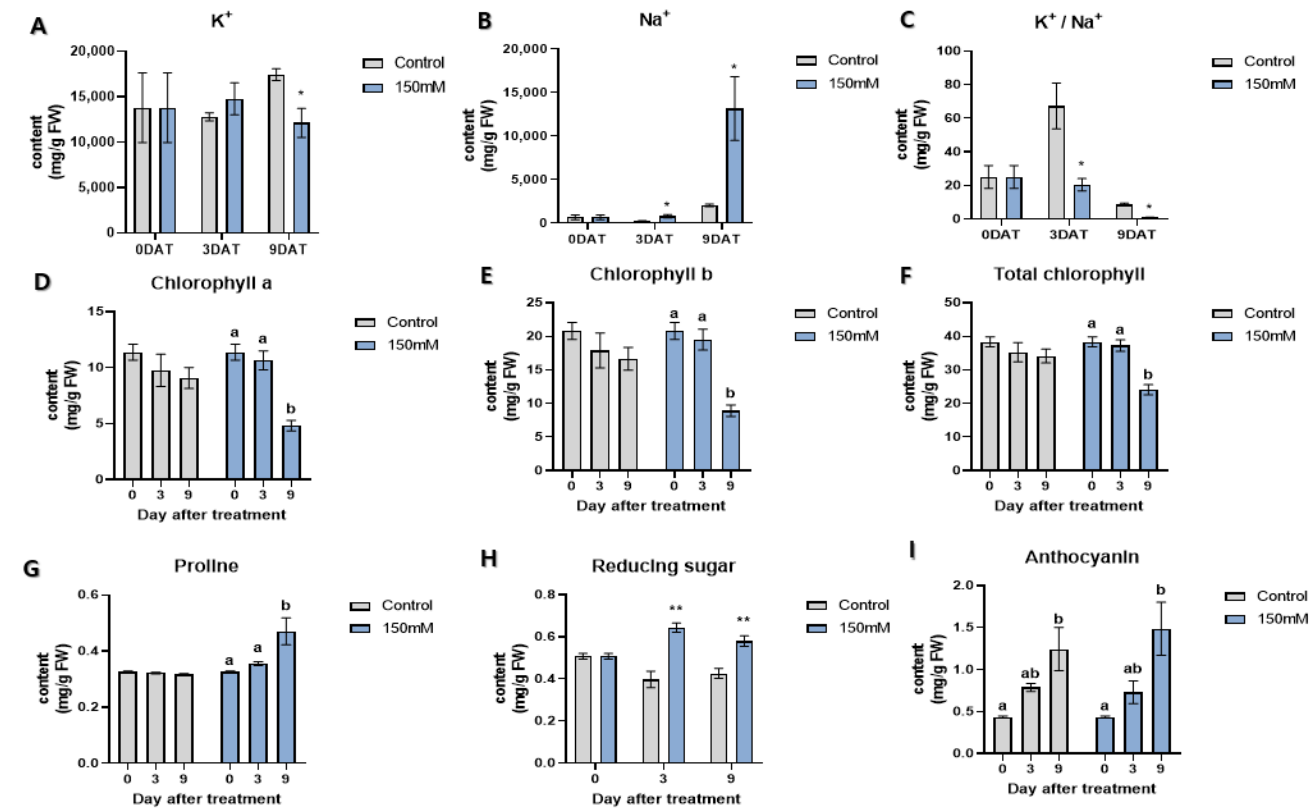
Figure 1. Physiological parameters under salt stress conditions in the leaves of Nampungchal culti- var. ( A ) Potassium content, ( B ) sodium content, ( C ) K + /Na + content, ( D ) chlrophyll a content, ( E ) chlorophyll b content, ( F ) total chlorophyll content, ( G ) proline content, ( H ) reducing sugar content, ( I ) anthocyanin content. a, b: Different letters indicate significant differences among different days (ANOVA followed by Tukey’s test at p < 0.05). * means p -value = 0.05, ** means p -value = 0.1.